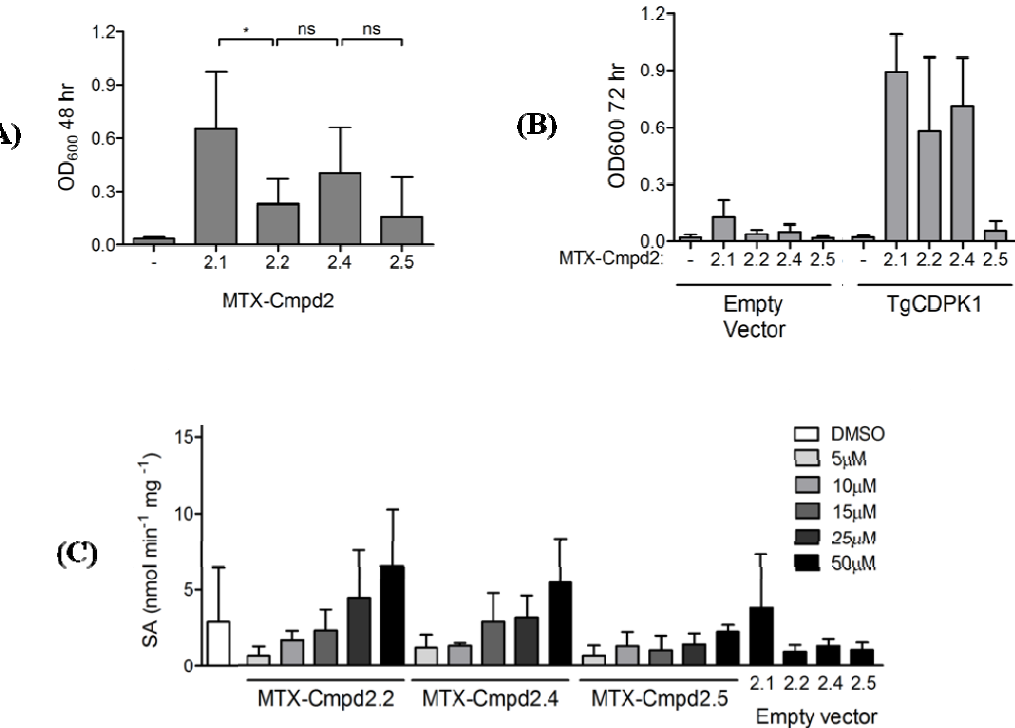
Figure 6. Effect of CID linker length on the Y3H interaction between compound 2 -based CIDs and TgCDPK1. ( A ) LEU2 reporter activation growth assay with yeast expressing a TgCDPK1-AD fusion protein in the presence of the MTX-Cmpd2 CID series with different linker lengths. Samples treated with the DMSO vehicle were used as negative controls. Mean values ± SD are shown (n ≥ 5) and compared using paired Student’s t-test; ( B ) LEU2 reporter activation growth assay as in panel A using yeast expressing TgCDPK1-AD; ( C ) β -Galactosidase assay in the presence of the MTX-Cmpd2 CID series with different linker lengths. Dose response curves with each CID are presented with the lowest dose corresponding to the vehicle (DMSO) treated samples. Mean values ± SD are shown (n ≥